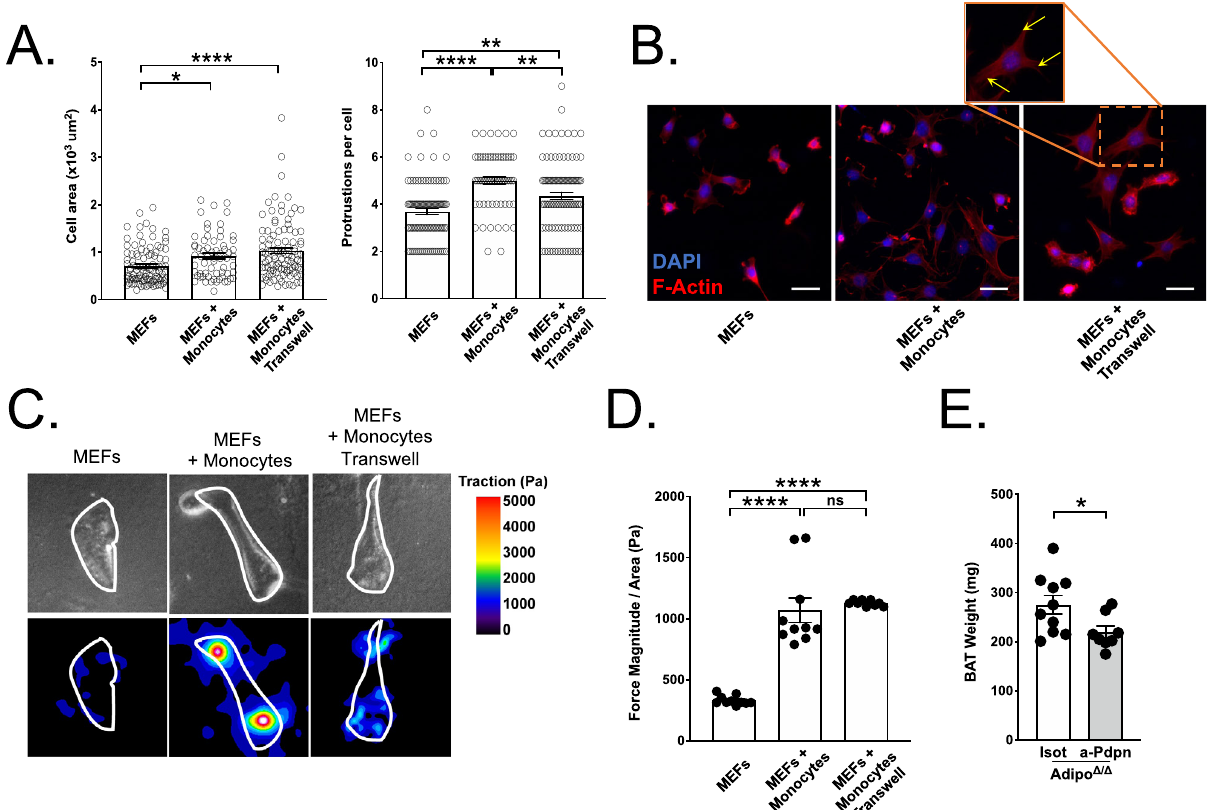
Fig. 5 Monocyte interaction with fi broblasts through the Podoplanin axis is required for BAT expansion. A Quanti fi cation of MEF morphological features after a 18 h co-culture experiment with monocytes placed in the same well or in a transwell insert with 0.4 μ m pores. Each dot represents a cell. n = 101 (MEFs), 64 (MEFs + Monocytes) and 103 (MEFs + Monocytes Transwell) cells representative of three independent experiments. *: p = 0.0257, ****: p = <0.0001 (left). **: p < 0.01, ****: p < 0.0001(right). B Representative images of MEF morphology after a 18 h co-culture experiment with monocytes placed in the same well or in a transwell insert with 0.4 μ m pores. F-actin was revealed using phalloidin staining. Yellow arrows indicate protrusions. Scale bar = 20 μ m. Representative heat map ( C ) and quanti fi cation ( D ) showing contractile forces generate by MEFs plated on 8 kPa hydrogel after a 18 h co-culture experiment with monocytes placed in the same well or in a transwell insert with 0.4 μ m pores. Mean of n = 10 wells per condition. ****: p < 0.0001. E Brown adipose tissue weight in anti-Podoplanin ( n = 8) or isotype control-treated ( n = 10) Adipo Δ / Δ mice. p = 0.0363. Panels A , B are representative of three independent experiments. Panel D is representative of two independent experiments. Panel E represents pooled data from two independent experiments. All data are represented in means± SEM. Ordinary one-way ANOVA with Bonferroni post-test were used to determine statistical signi fi cance in panels ( A , D ). A two-tailed Mann − Whitney test was used to determine statistical signi fi cance in panel ( E ). ns p > 0.05; * p < 0.05; ** p < 0.01; *** p < 0.001. Source data are provided as a Source Data fi